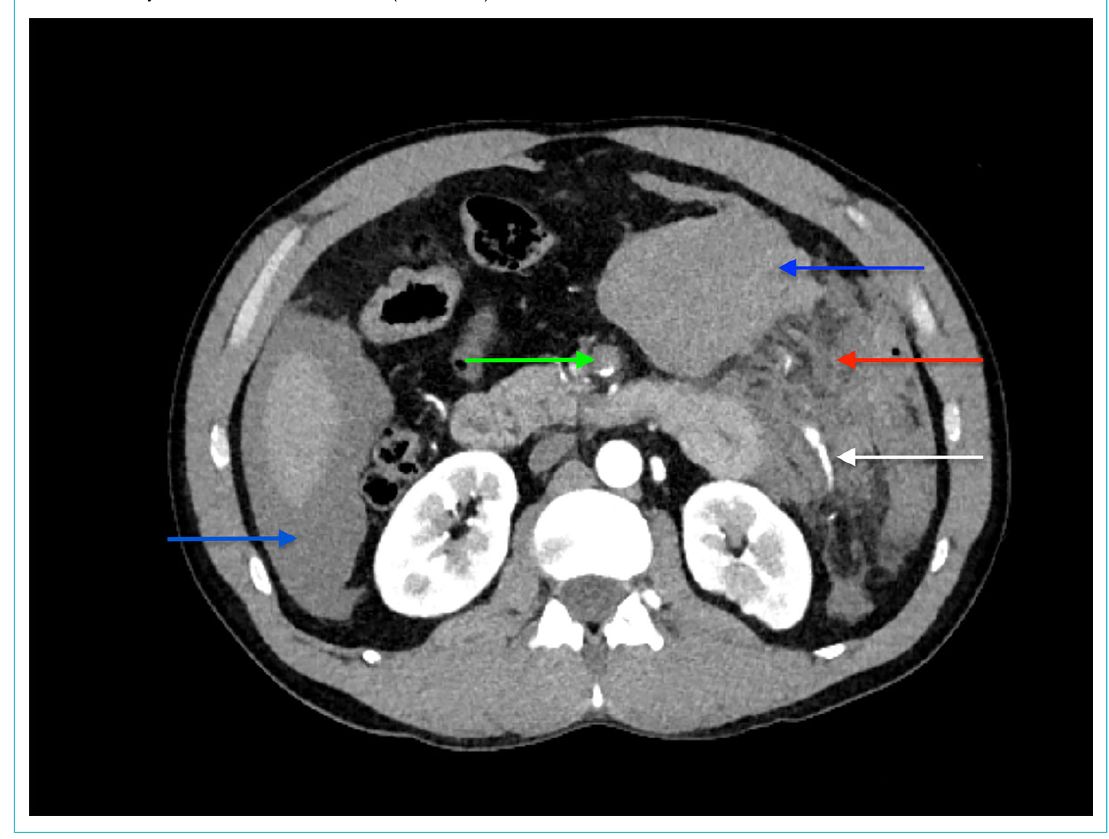
Figure 1: Emergency abdominal CT scan showing massive haemoperitoneum (blue arrows), dissection of the superior mesenteric artery (green arrow), misty aspect of the mesentery of the left colon (red arrow) and pathological ascending branch of the left colonic artery with stric- tures and aneurysms and without contrast blush (white arrow).